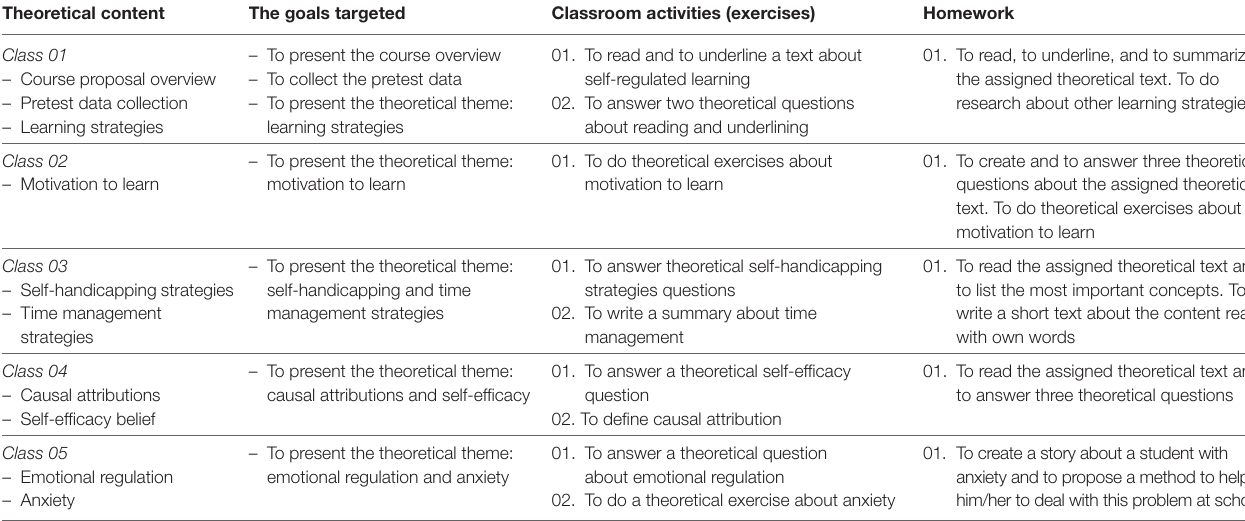
TaBle a2 | Overview of course content, classroom activities and the goals targeted in the traditional course format (Experimental Group II). a